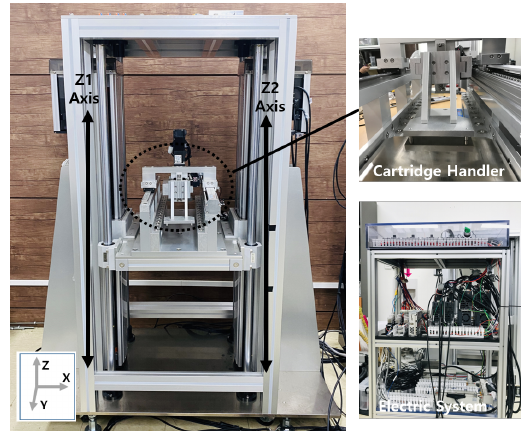
Figure 12. Cartridge transport robot in multi-probe wafer-inspection system.